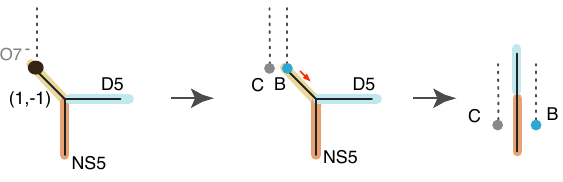
Figure 9 . Resolution of the O 7 (cid:0) plane attached to (1 ; (cid:0) 1) 5-brane. A [1 ; (cid:0) 1] 7-brane is denoted by B and a [1 ; 1] 7-brane is denoted by C